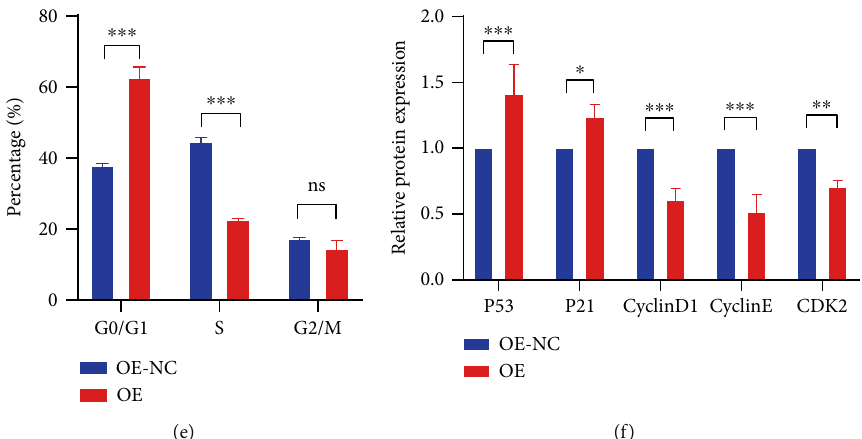
Figure 8: PTPRG overexpression depressed EMT and mediated cell cycle arrest. (a) The optical density detected in 0h, 24h, 48h, and 72h indicates the cell viability in CCK8 assay. (b) The western blot bands of the EMT-related protein expression (left) and their statistical comparison (right). (c) The fl ow cytometry results of the G0/G1, S, and G2/M phase cell cycle proportion. (d) The western blot bands of the G1/S phase transition-related protein expression. (e, f) The statistical comparisons of the cell cycle proportion (e) and G1/S phase transition-related protein expression (f) between OE and OE-NC